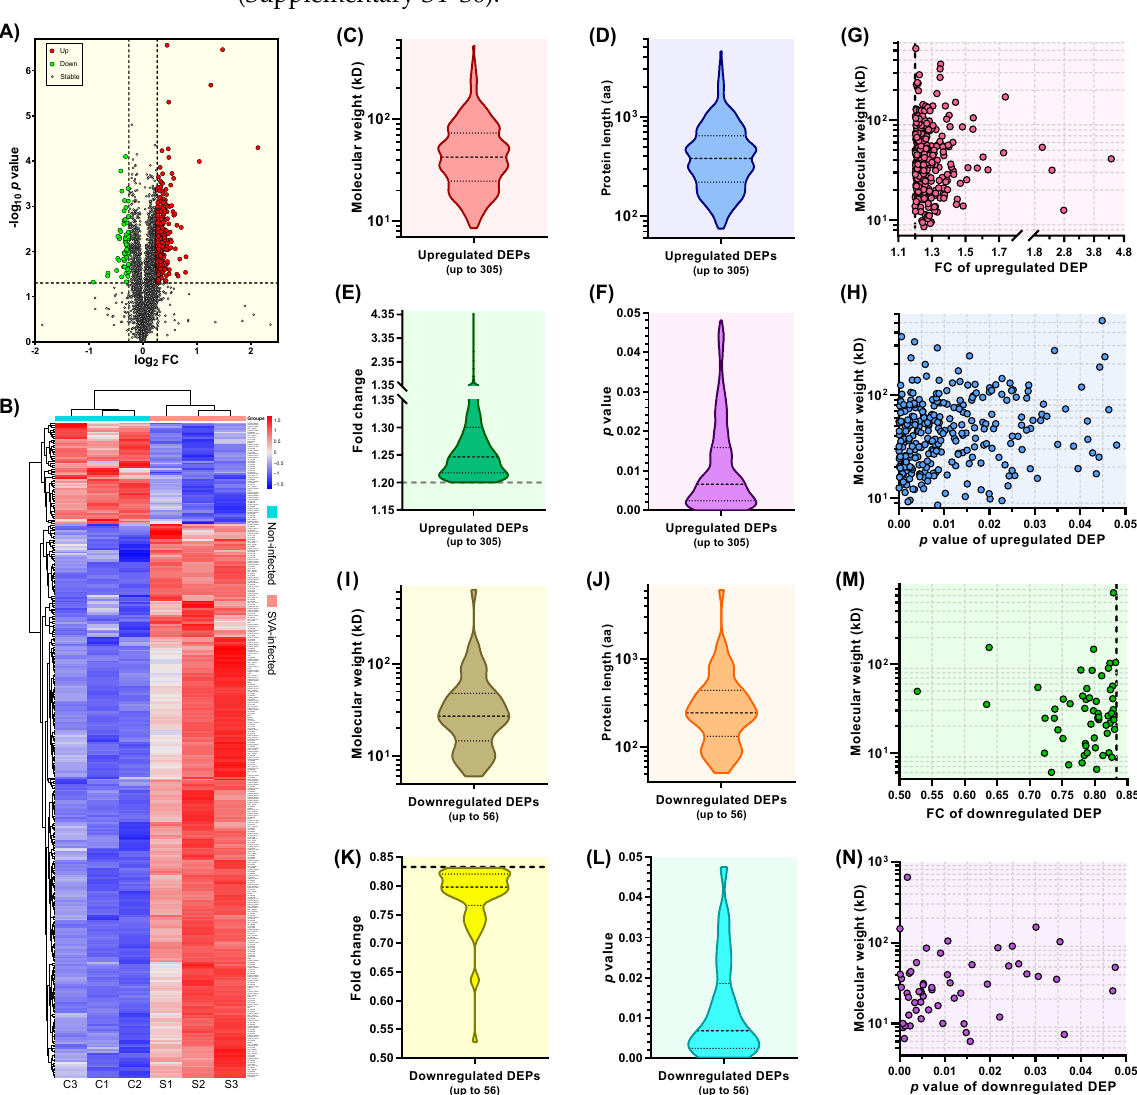
Figure 3. Profiles of upregulated and downregulated DEPs. Volcano plot of all 5301 proteins identified in the six groups ( A ). Up: upregulated DEPs (FC > 1.2 and p value < 0.05); Down: downregulated DEPs (FC < 0.833 and p value < 0.05); Stable: proteins neither significantly upregulated nor significantly downregulated (0.833 ≤ FC ≤ 1.2 or p value ≥ 0.05). Heatmap with hierarchical clustering of 361 DEPs (FC > 1.2 or < 0.833 and p value < 0.05) ( B ). The intensity of color reflects the degree of change. Red: highly expressed DEPs; blue: lowly expressed DEPs. Violin-plot-exhibited distributions of molecular weight ( C ), protein length ( D ), FC ( E ) and p value ( F ) for all 305 upregulated DEPs. Corresponding relations between the molecular weight and FC ( G ) and p value ( H ) for each upregulated DEP. Violin-plot-exhibited distributions of molecular weight ( I ), protein length ( J ), FC ( K ) and p value ( L ) for all 56 downregulated DEPs. Corresponding relations between the molecular weight and FC ( M ) as well as p value ( N ) for each downregulated